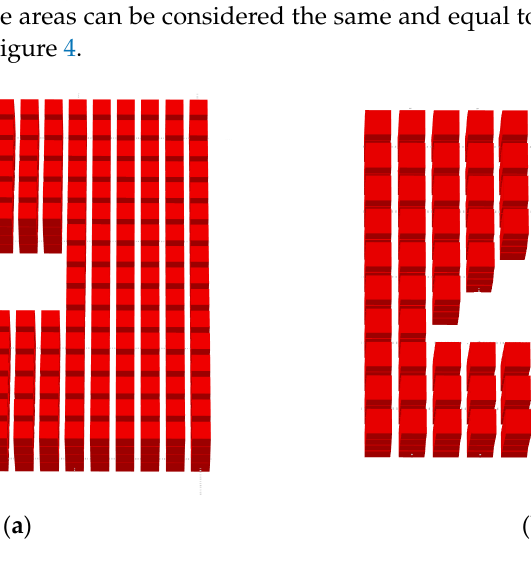
. The height of the triangle is